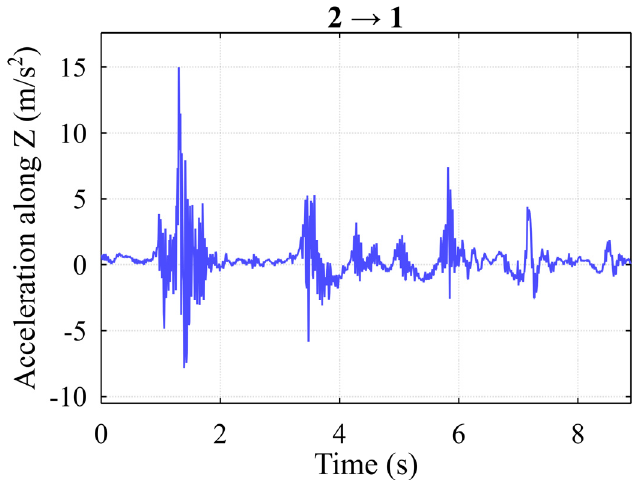
Figure 8. Spreader accelerations along the Z-axis: Example B.